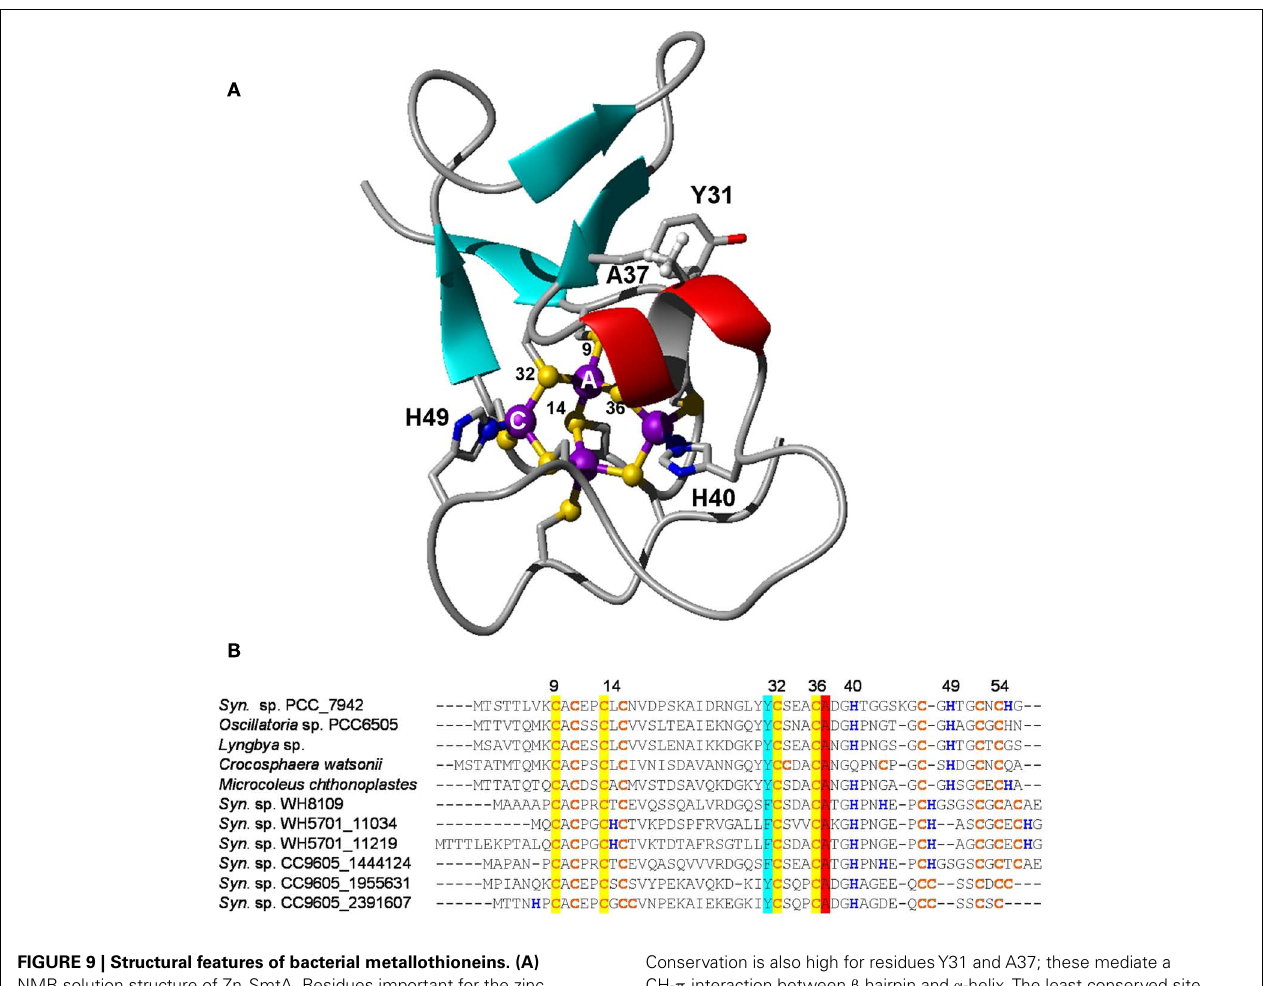
FIGURE 9 | Structural features of bacterial metallothioneins. (A) NMR solution structure of Zn 4 SmtA. Residues important for the zinc finger fold and metal ligands are highlighted. (B) Selected primary sequences of BmtAs from marine cyanobacteria.The level of conservation is different for different metal sites. Site A, the zinc finger site, is fully conserved, as it is required for structural stability.